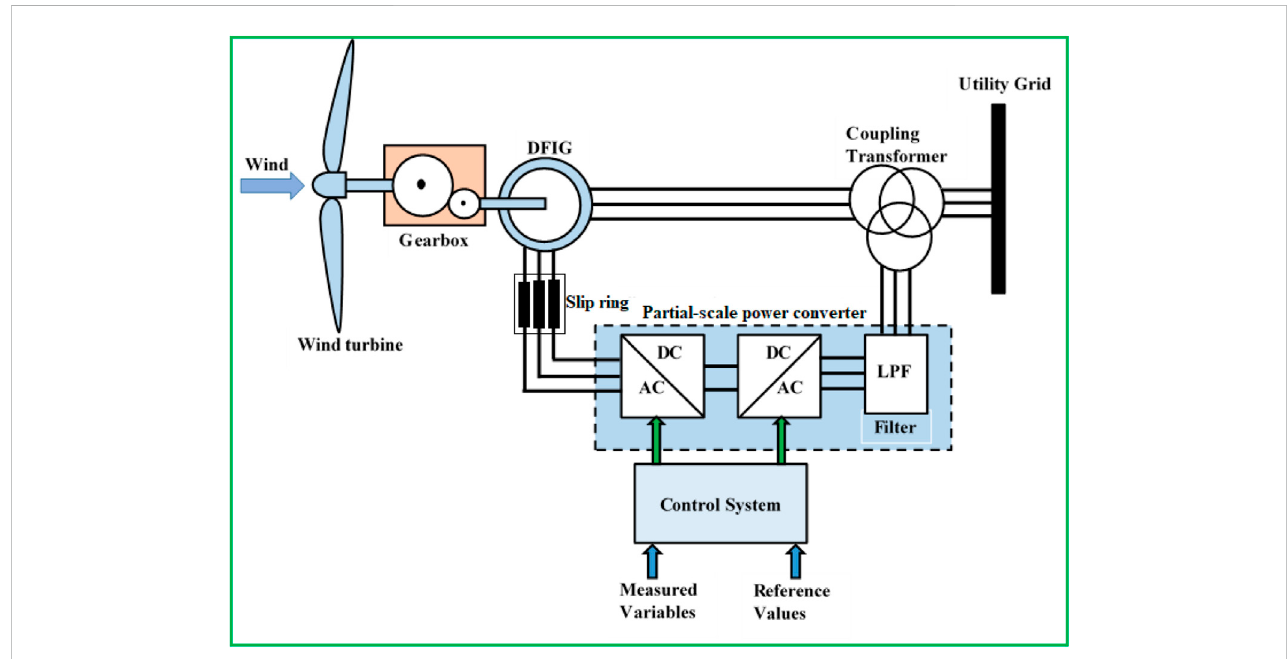
FIGURE 3 Topology of DFIG-based wind energy conversion technology.